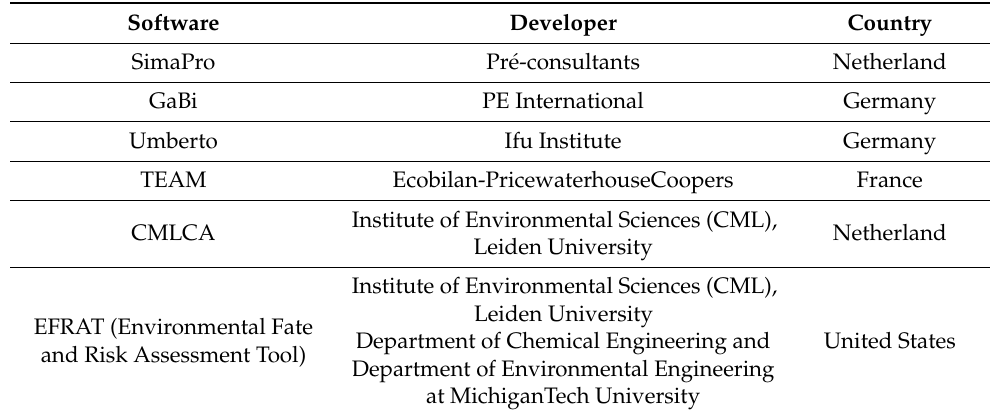
Table 3. Life cycle assessment tools used in reviewed